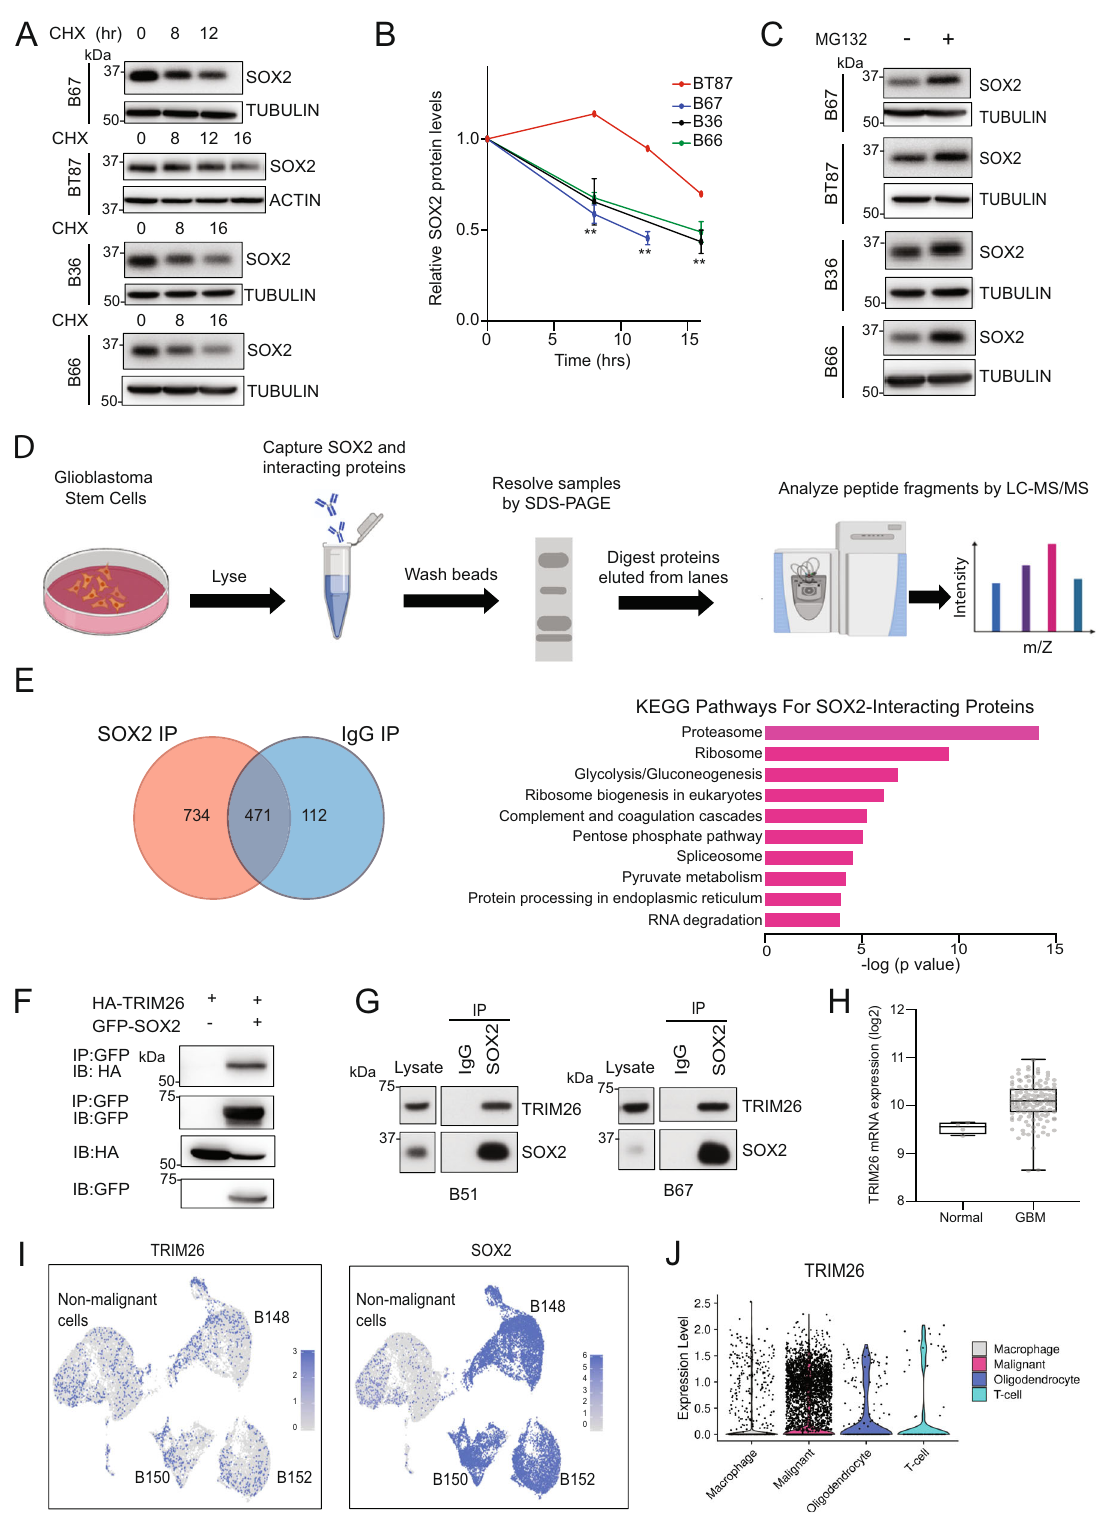
suggesting TRIM26-dependent regulation of SOX2 at the post- transcriptional level. Indeed, the decrease in endogenous SOX2 protein levels triggered by TRIM26 knockdown could be reversed by treatment with proteasome inhibitor MG132 (Fig. 2C), and cycloheximide chase experiments revealed that TRIM26 knock- down in GSCs increased the rate of SOX2 protein degradation relative to control (Supplementary Fig. 3B). Together, these results